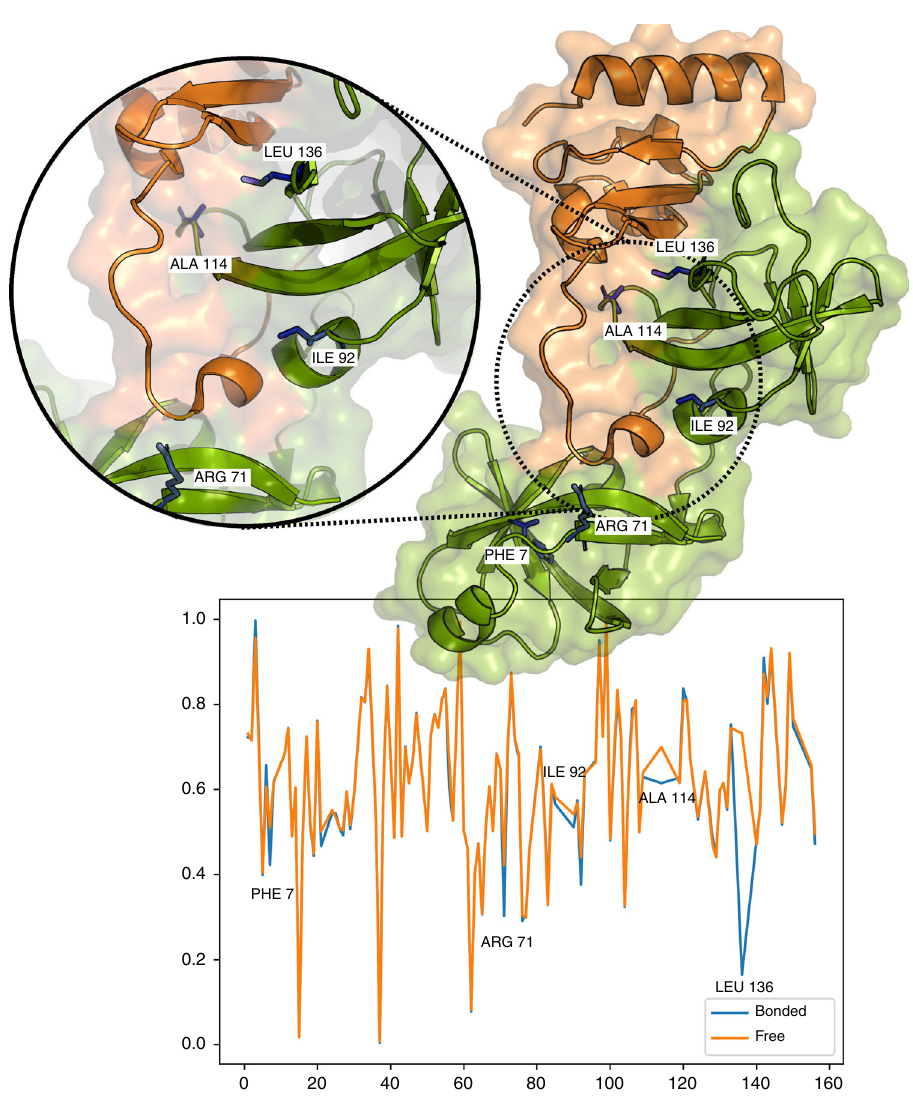
Fig. 5 Comparison between the free and bonded state of the RimM protein. The bottom part of the fi gure shows the ShiftCrypt pro fi le for the bounded (orange) and free (blue) states. The upper part shows its relation with the structure: the RimM (in green) in complex with the ribosomal protein S19 (in orange). The fi ve blue residues are the ones that are reported to change their ShiftCrypt value the most. Since in these proteins there are several missing values, the analysis has been carried out using only the most common atoms (H, C α , and N) in order to calculate the ShiftCrypt